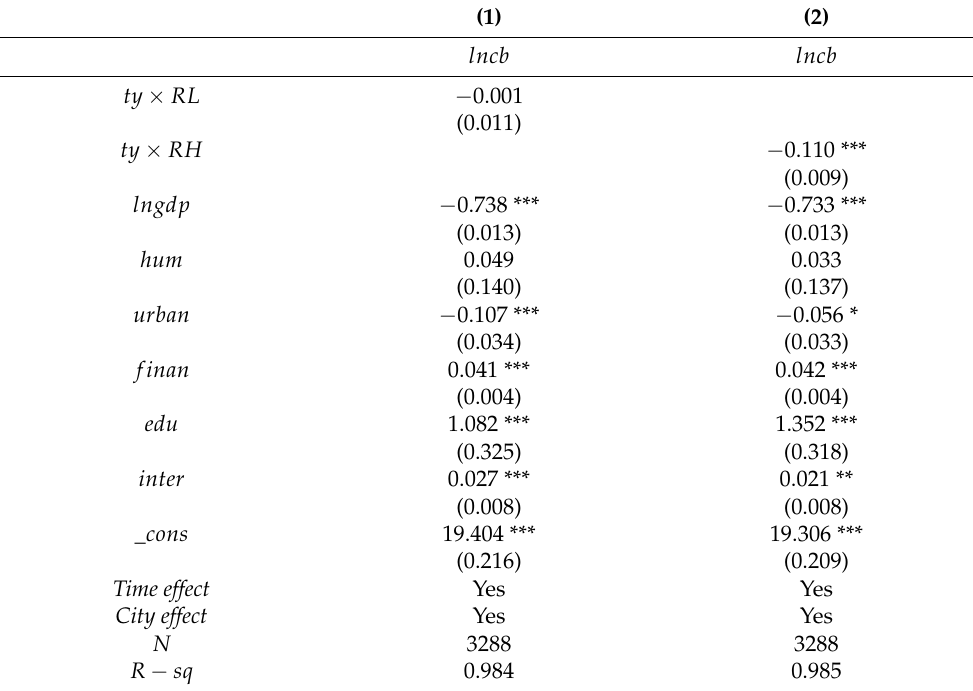
Table 3. Heterogeneity of city